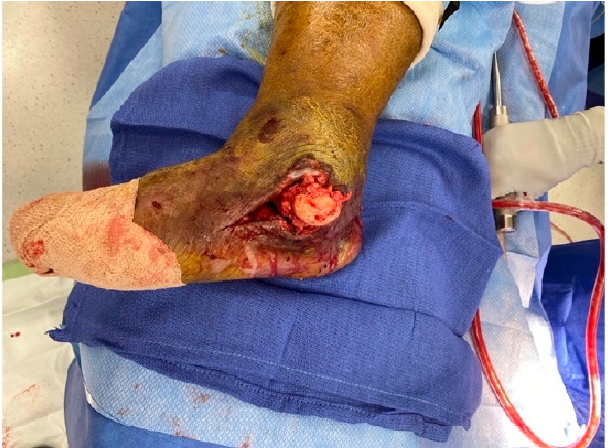
Figure 2. Medial incision.